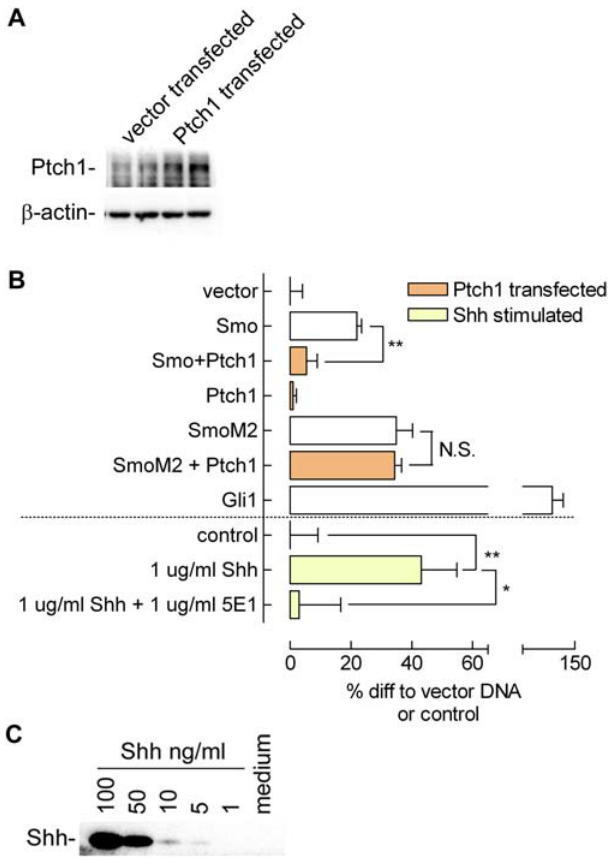
Figure 2. Confirmation of Functionality of Constructs and Model System Used (A) Transfection of Ptch1 expression construct in C3H/10T1/2 fibroblasts increased Ptch1 expression over basal expression, as seen on Western blot. Actin levels remained unaltered; cells were lysed 24 h post transfection. (B) C3H/10T1/2 cells are sensitive to Hh pathway components as indicated by Gli reporter activity when pathway components